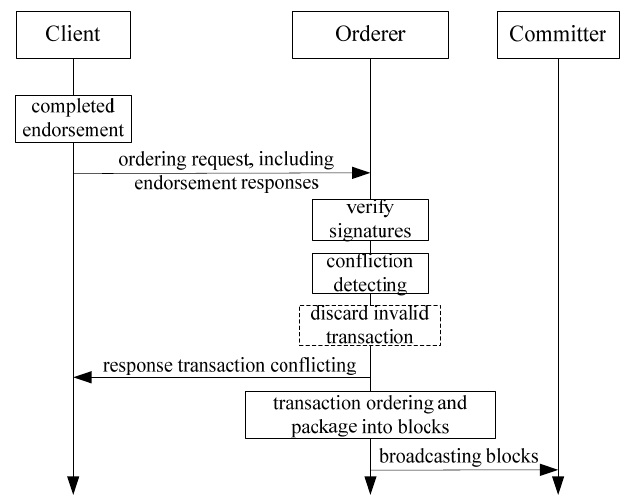
Figure 4. Optimized ordering processing flow of Fabric.